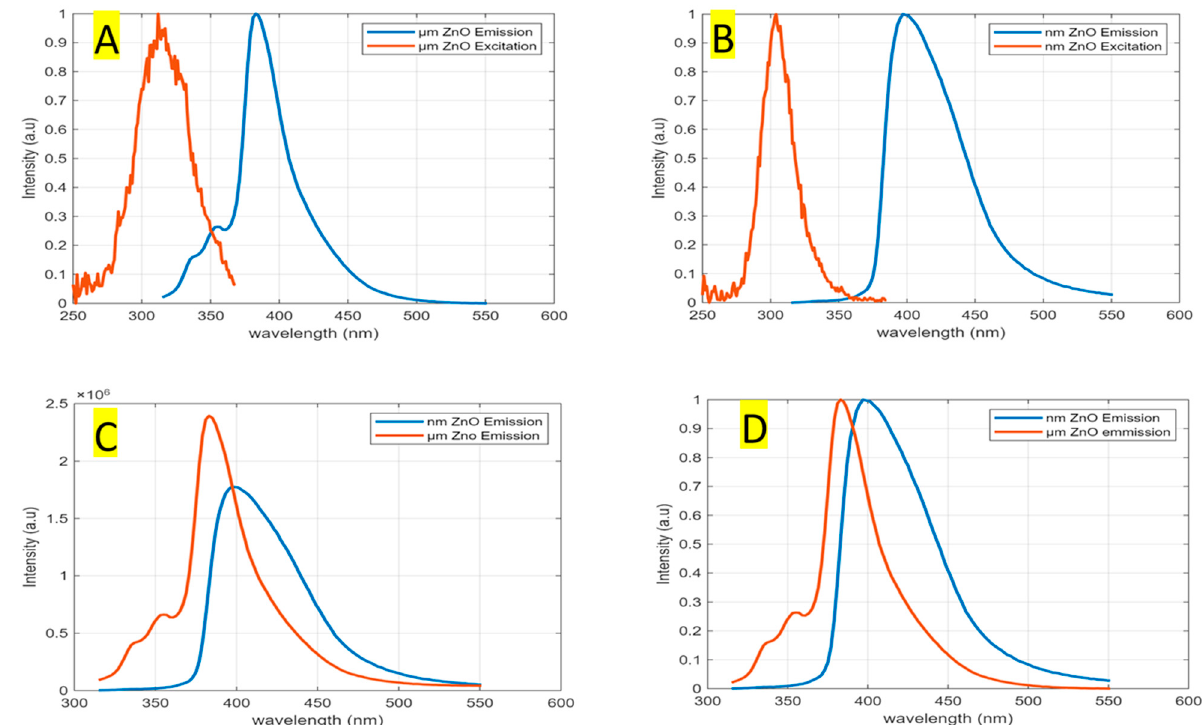
Figure 5. ( A ) microparticles emission and excitation spectrum of ZnO, ( B ) ZnO NPs emission and excitation spectrum, ( C ) ZnO particle size fluorescent emission contrast, and ( D ) ZnO particle size fluorescent excitation contrast.